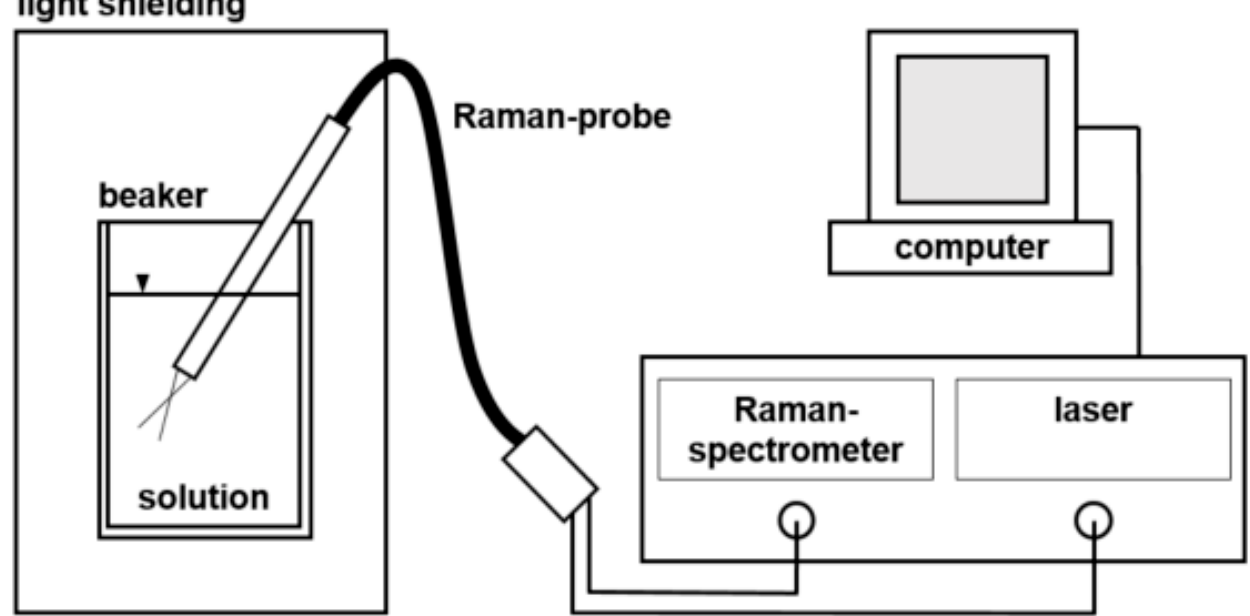
Figure 1. Experimental setup of Raman measurement.